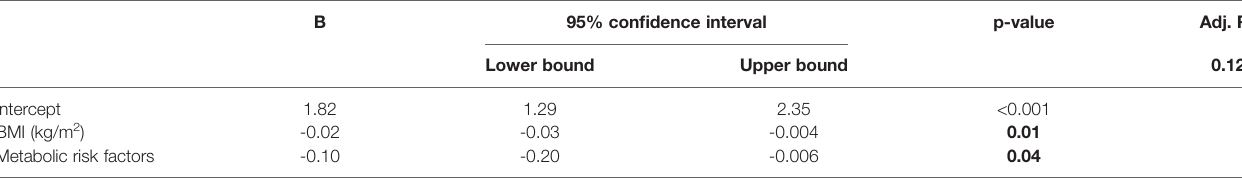
TABLE 4 | Linear regression identifying pre-treatment factors predictive for BMI SDS loss during inpatient treatment after removal of non-signi fi cant terms (n=87).